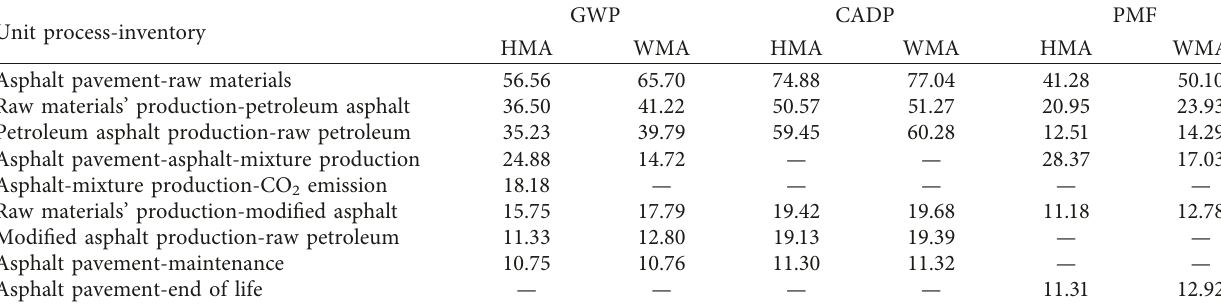
Table 6: The sensitivity of GWP, CADP, and PMF with the corresponding unit